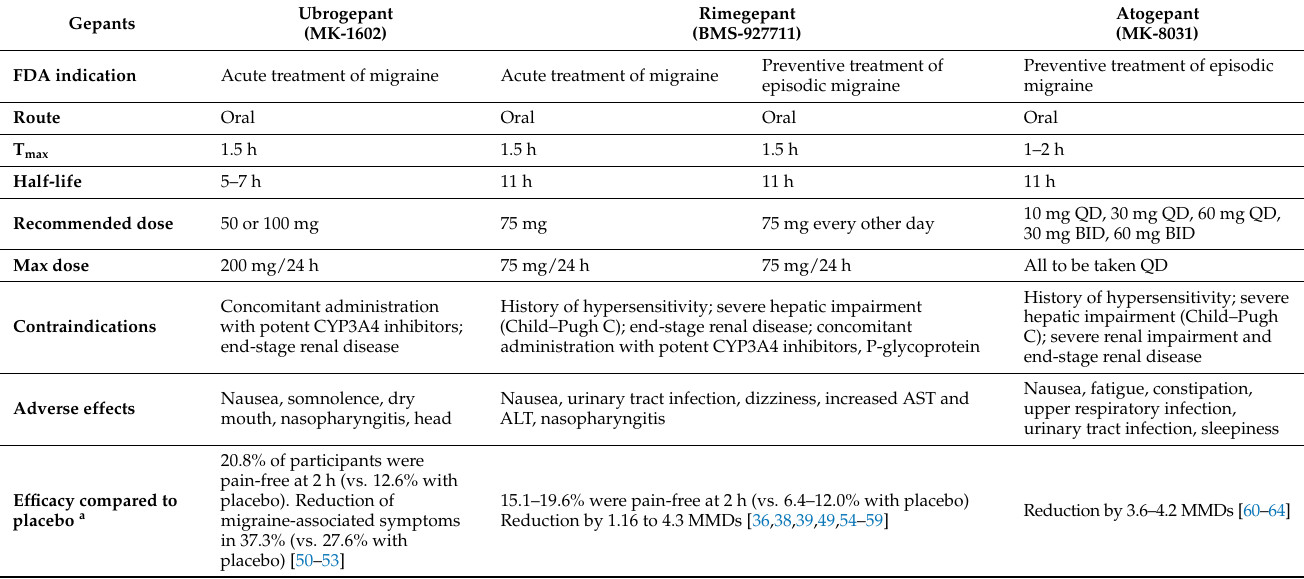
Table 1. FDA-approved gepants for the treatment of acute and preventive migraine in adults. ALT: alanine aminotransferase; AST: serum aspartate aminotransferase; BID: twice per day; FDA: Food and Drug Administration; QD: once per day; MMD: monthly migraine days; T max : time to maximum concentration. a Results according to available